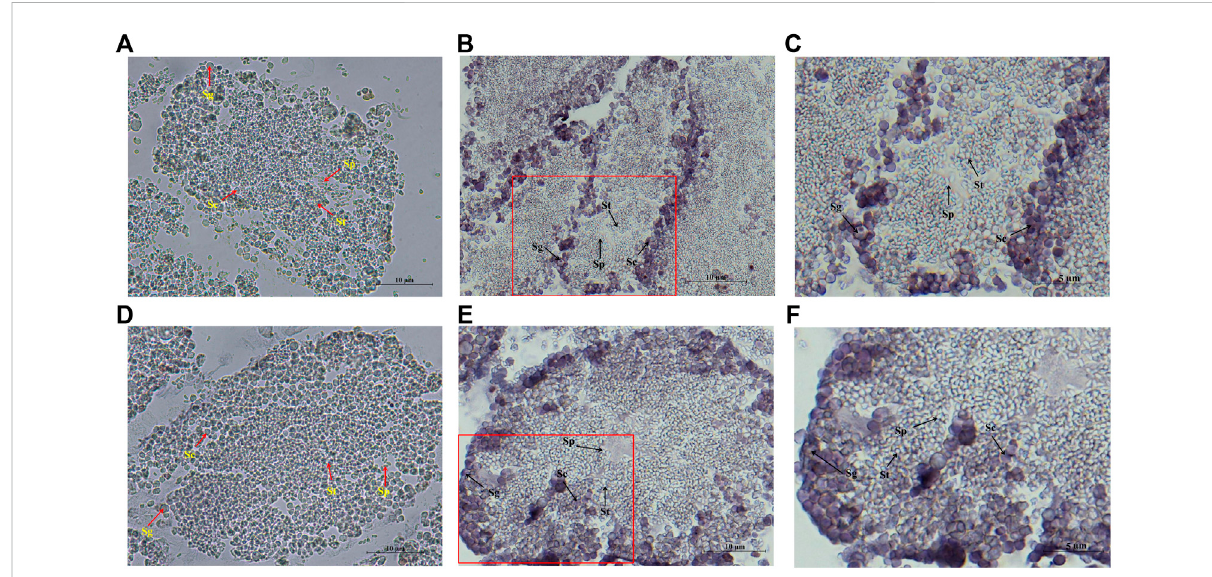
FIGURE 8 In situ hybridization of Hc-Tex11 and Hc-Meig1 genes in testes, (A) Hc-Tex11 control group, (B) Hc-Tex11 experimental group, (C) magni fi ed image of Hc-Te×11 experimental group, (D) Hc-Meig1 control group, (E) Hc-Meig1 experimental group, (F) magni fi ed image of Hc-Meig1